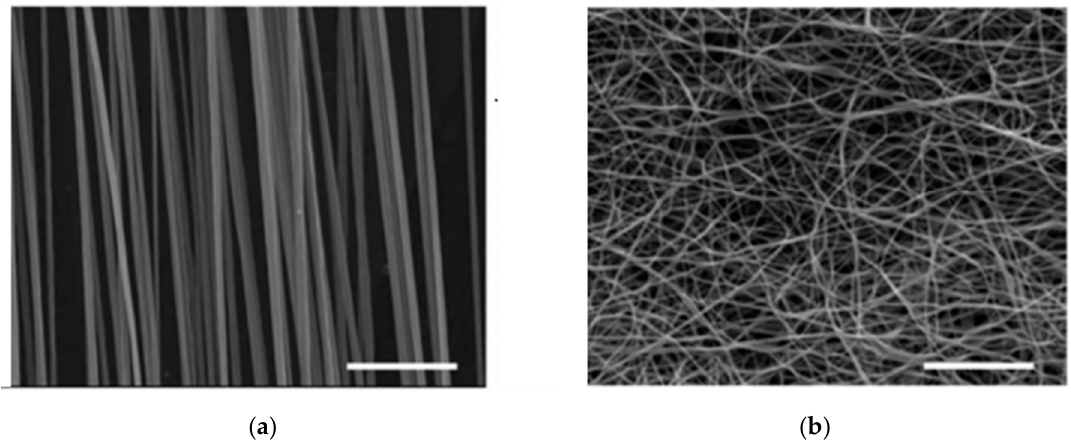
Figure 2. Different types of fibers: ( a ) aligned fibers and ( b ) randomly oriented fibers (adapted from [43]) (Copyright permission: Direct cryopreservation of adherent cells on an elastic nanofiber sheet featuring a low glass-transition temperature O. Batnyam, S. Suye and S. Fujita, RSC Adv., 2017, 7, RSC Advances DOI: 10.1039/C7RA10604A).